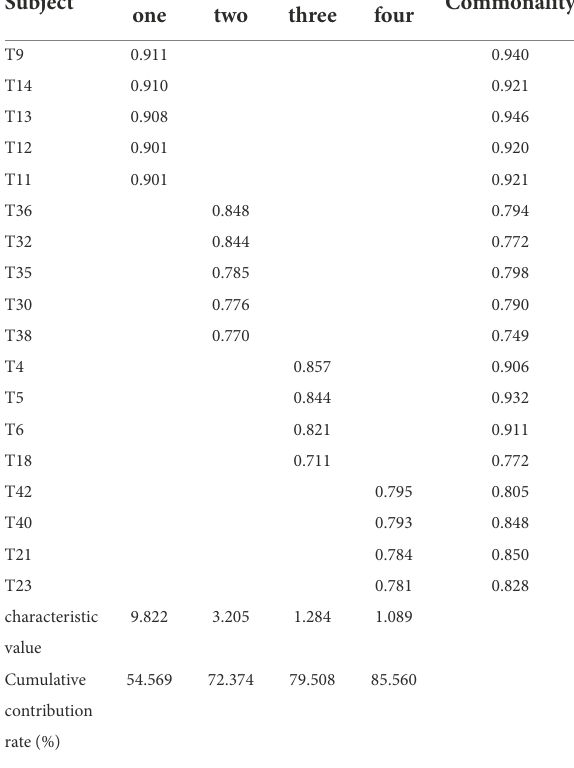
TABLE 3 Exploratory factor analysis.